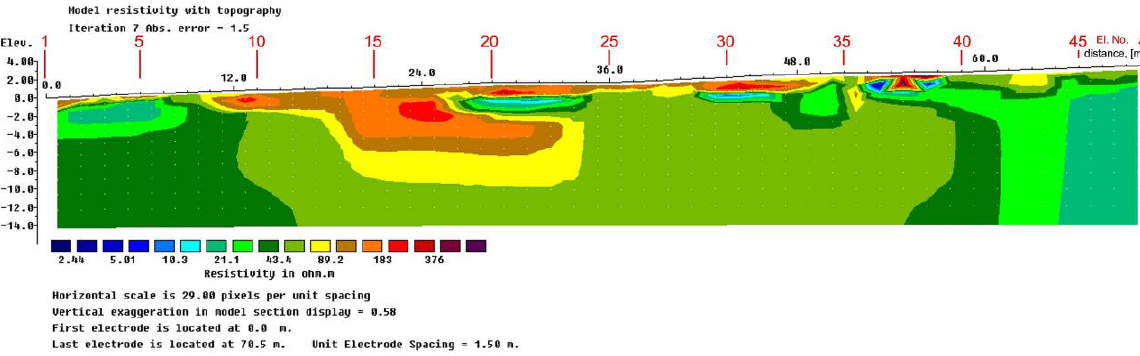
Figure 13. The distribution of the apparent resistivity based on the measurement with the Wenner–Schlumberger array.